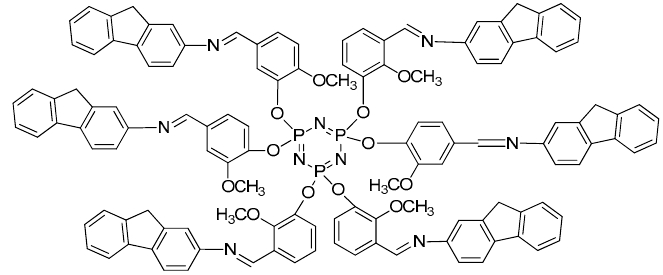
Figure 14. Molecular structure of compound 17b [57].